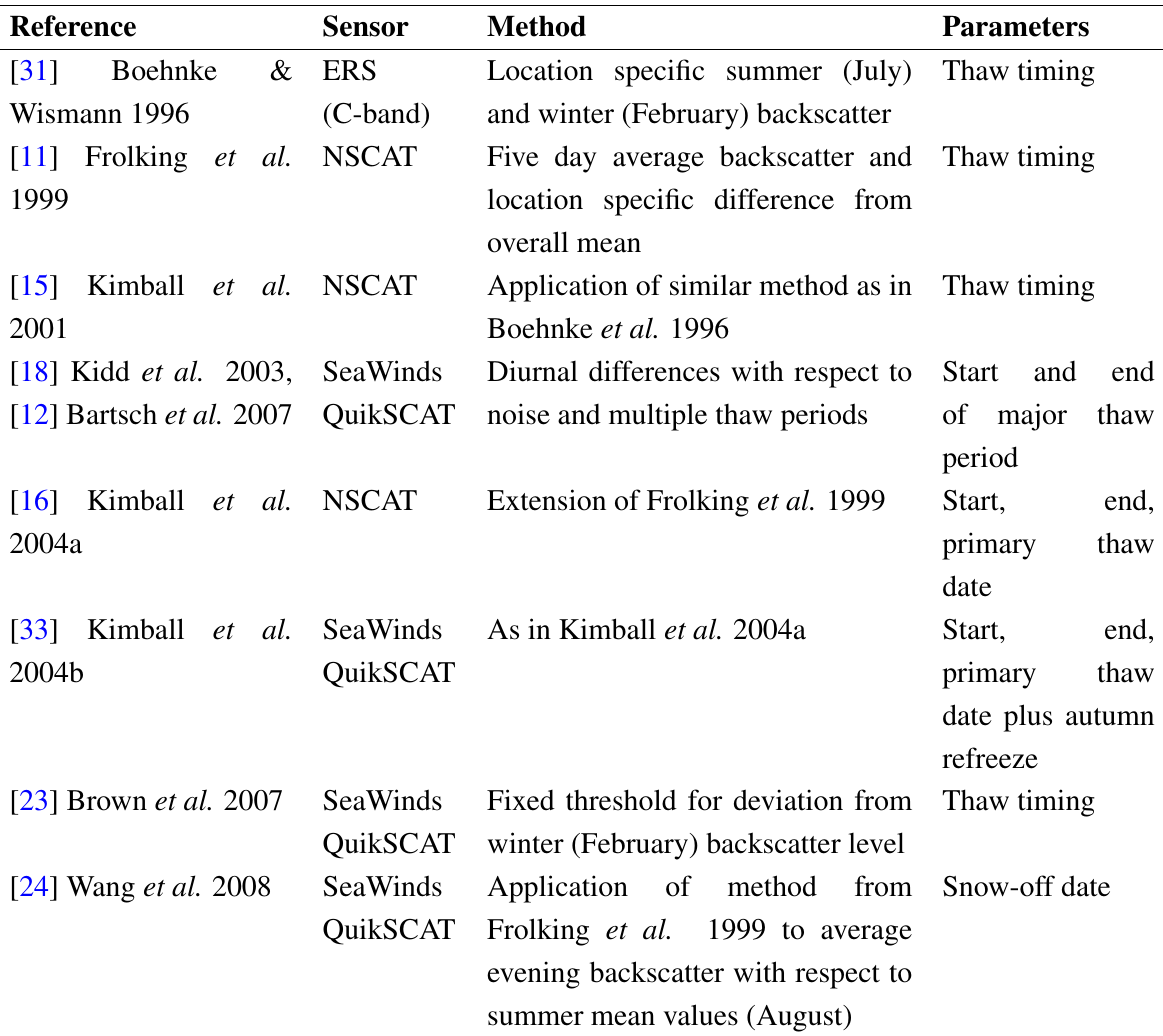
Table 2. Methods and parameters of spring snowmelt products from spaceborne